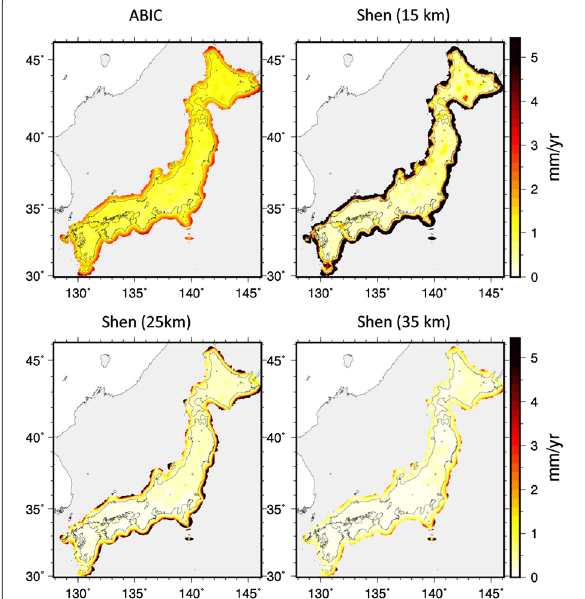
Fig. 14 Comparison of the estimation errors in terms of the absolute value of dilatation rates. Results of different D values are presented for Shen’s